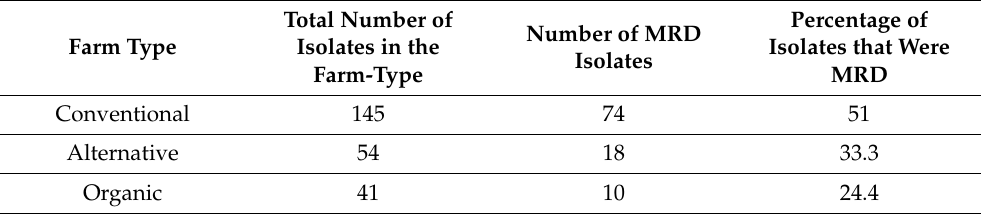
Table 1. Origin of phenotypic MRD isolates ( n = 102) displaying resistance against more than two different antimicrobial classes.